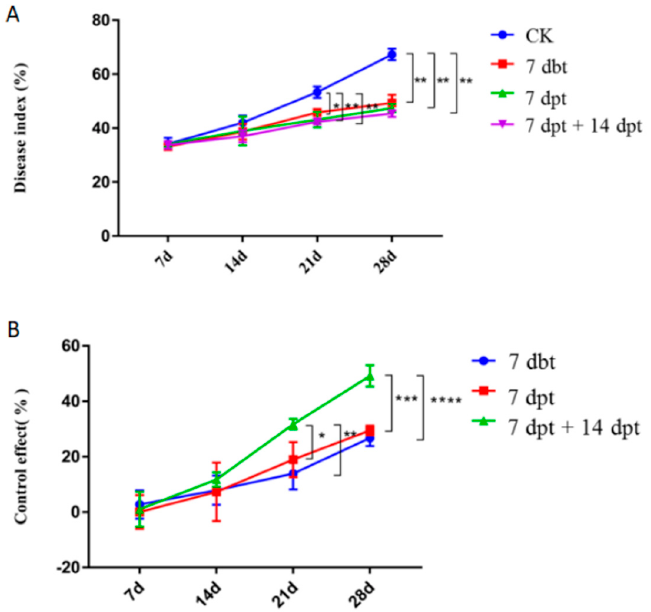
Figure 3. Disease index values ( A ) and control effects ( B ) in sugarcane with leaf scald disease at 7, 14, 21, and 28 d after Xa inoculation. Plants were treated with a synergistic bactericide at different time points before or after inoculation with Xa . dbt, days before treatment; dpt, days post-treatment. Data are presented as the mean ± standard error ( n = 3). * indicated significance with p ≤ 0.05 (ANOVA and Tukey’s HSD), ** indicated significance with p ≤ 0.01 (ANOVA and Tukey’s HSD), *** indicated significance with p ≤ 0.005 (ANOVA and Tukey’s HSD) and **** indicated significance with p ≤ 0.001 (ANOVA and Tukey’s HSD).